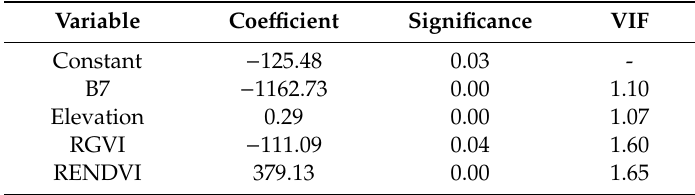
Table 5. Statistical results of the linear stepwise regression (LSR)